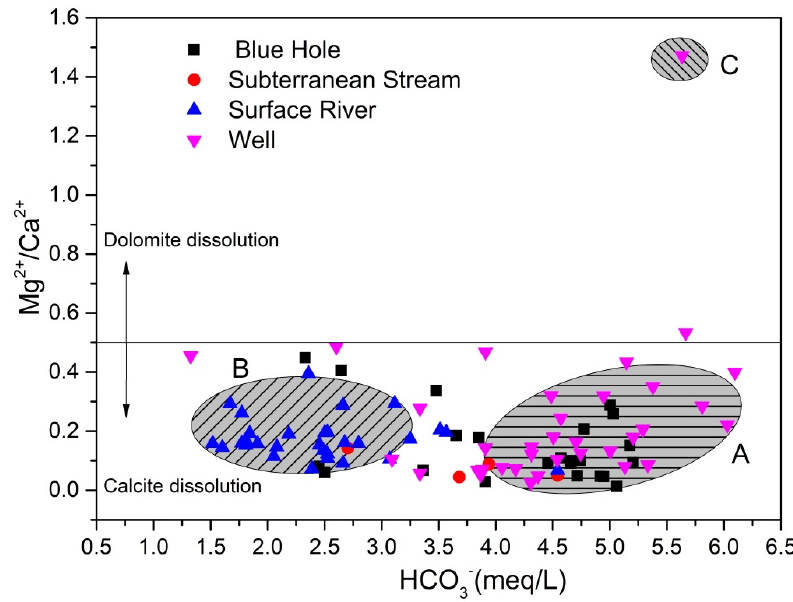
Figure 10. Relationship between HCO 3 − and Mg 2+ /Ca 2+ in groundwater of the Huixian karst wetland.